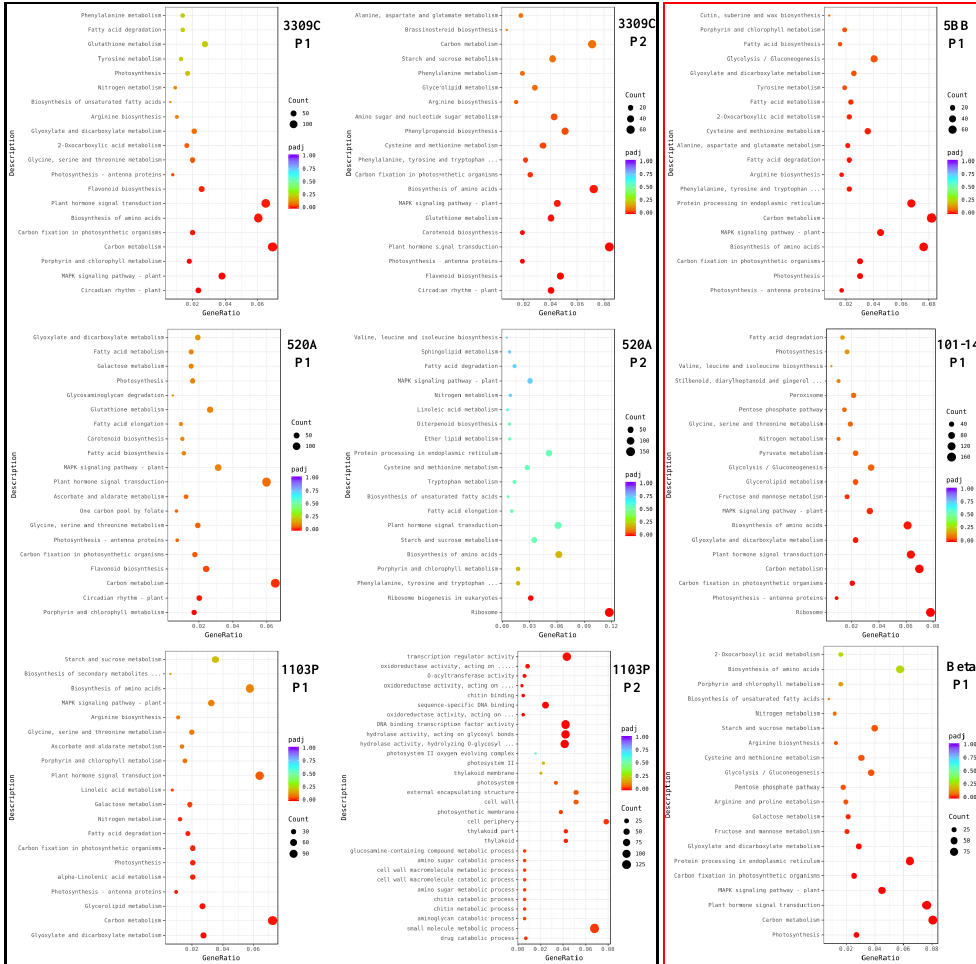
Figure 3. Kyoto Encyclopedia of Genes and Genomes (KEGG) pathways analysis of significantly enriched DEGs in rootstocks. GeneRatio represents the ratio of the number of DEGs annotated to the KEGG pathway to the total number of DEGs. Count represents the number of DEGs annotated to the KEGG pathway. padj represents the p -value corrected by multiple hypothesis